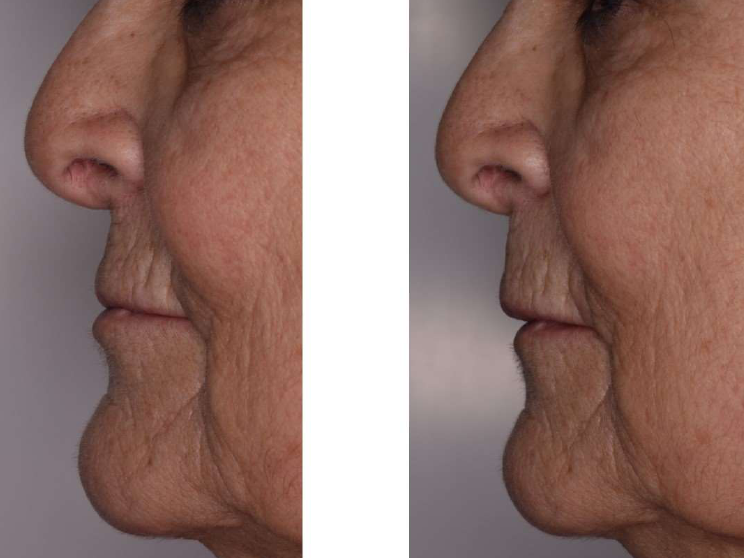
Figure 3. Patient profile without and with removable prosthesis with artificial